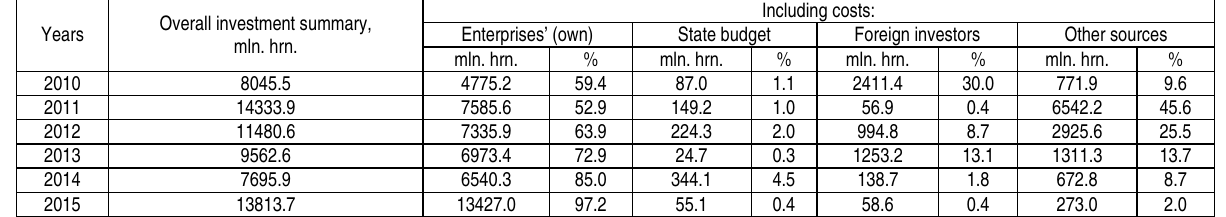
Table 1. The sources of innovation activity financing in Ukraine in 2010-2015, mln. hrn. [2] Overall investment summary, Years mln.